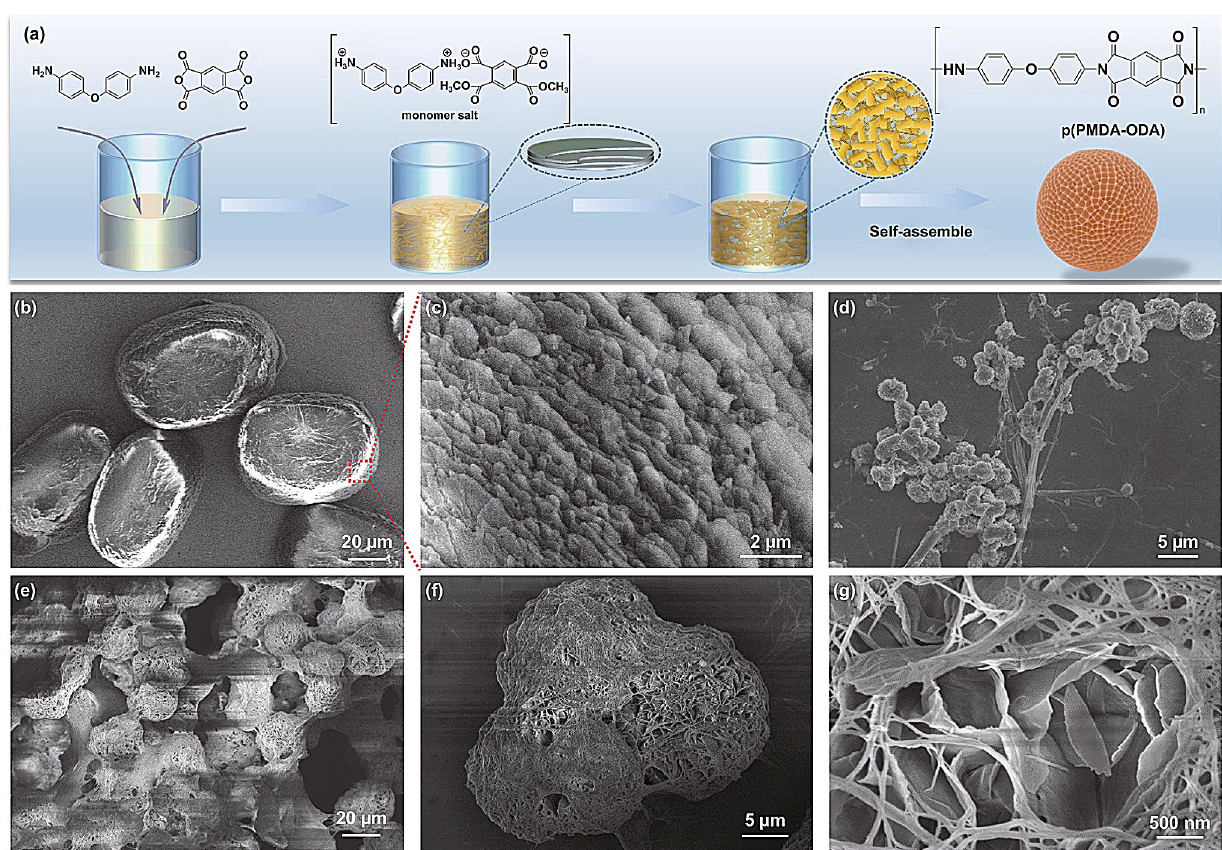
Fig. 1 Synthesis of polyimides (PIs). ( a ) Schematic of PI synthesis. ( b, c ) SEM images of [ODA 2+ PMDA 2− ] salts at different magnifications. ( d ) Products obtained by polymerization at 160 °C for 10 min. ( e–g ) Products covered with PVP at different magnifications (polymerization at 160 °C for 2